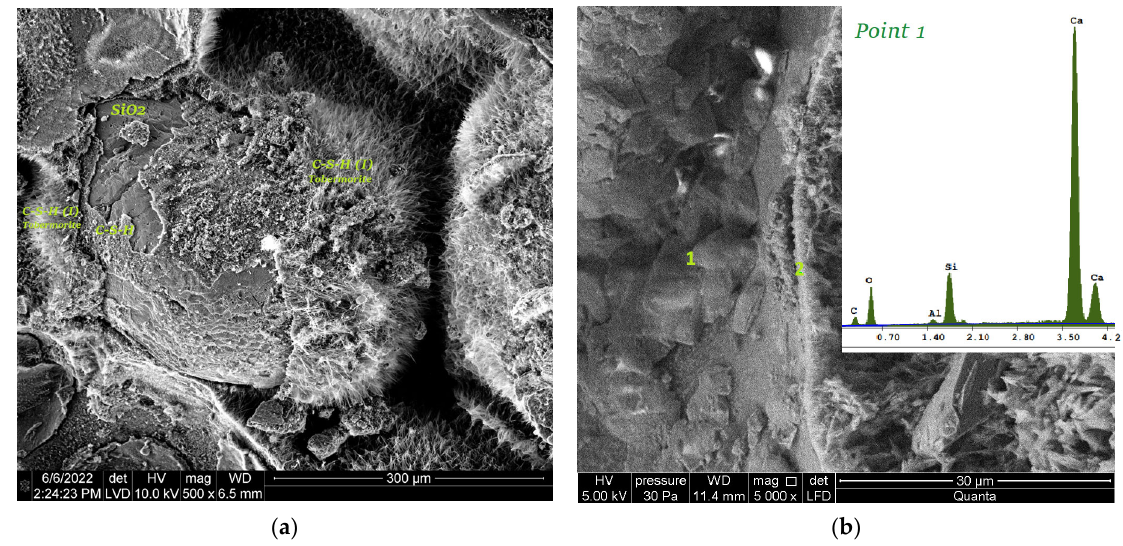
Figure 16. Microstructure of traditional (reference) silicate brick observed under a scanning electron microscope (SEM); ( a ) microstructure of the material 36 months after the laboratory production of traditional silicate bricks with quartz sand, 300 µ m magnification; ( b ) the microstructure of a reference brick with EDS spectrum, 30 µ m